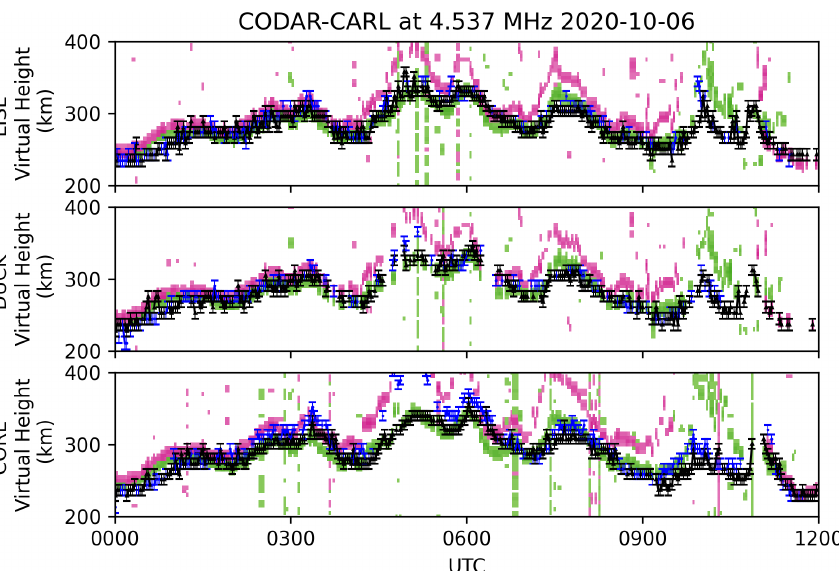
Figure 6. An example of virtual height observations of an assumed TID on 6 October 2020 from 00:00–12:00UTC. The format is similar to the top three rows of Fig. 4. The virtual height derived from CODAR observations for the X and O mode are shown as black triangles and blue dots, respectively. We also show uncertainty estimates for the virtual height. More details can be found in the